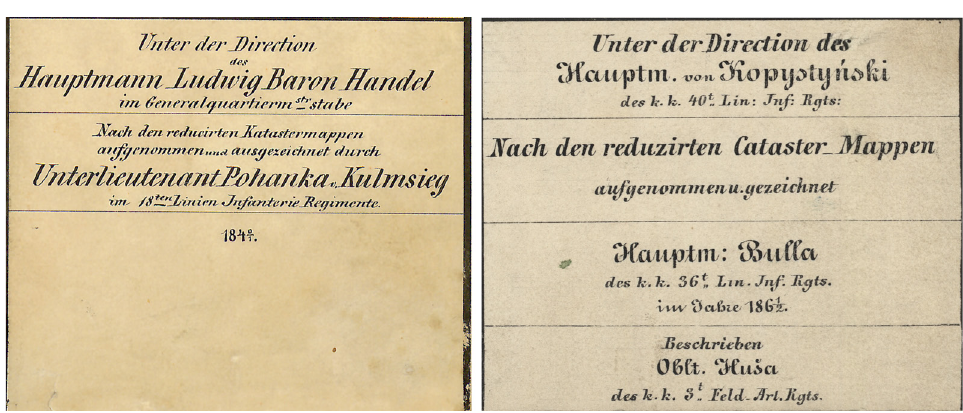
Fig. 1. Information on the sheet margins regarding authorship: for Austrian Silesia, Sect. 1, oestliche Col. III (left) and Galicia, Sect. 6, westliche Col. XXI